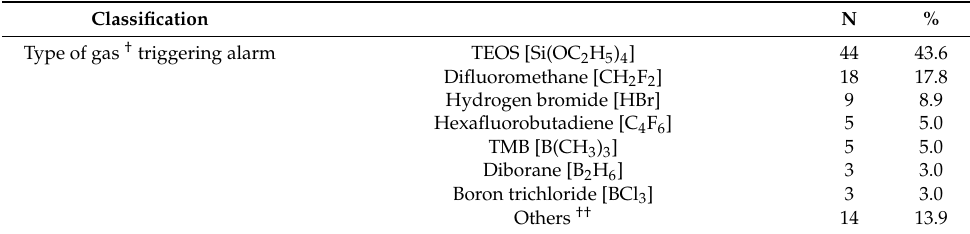
Table 6. Results of alarms ( n = 101) from gas detectors over 10 months from 2014 to